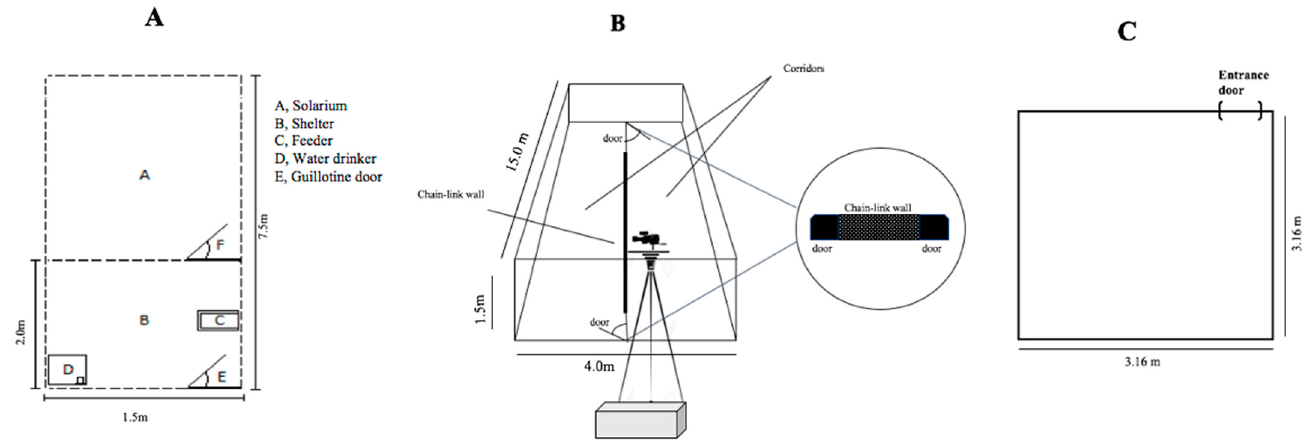
Figure 1. Diagrams of the pacas’ home pen ( A ); arena used for the modified defence test battery (MDTB) ( B ); and open field used during temperament assessment (novel-environment test) ( C ).